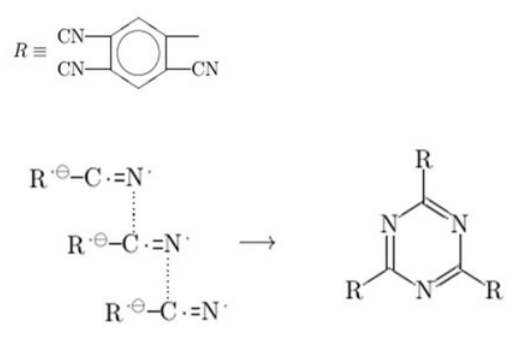
Figure Appendix A.2 . Possible reaction path on the TCNB side of the experiment (Fig A1). The R residual is depicted on the left hand upper side of the figure and is presented to provide details.